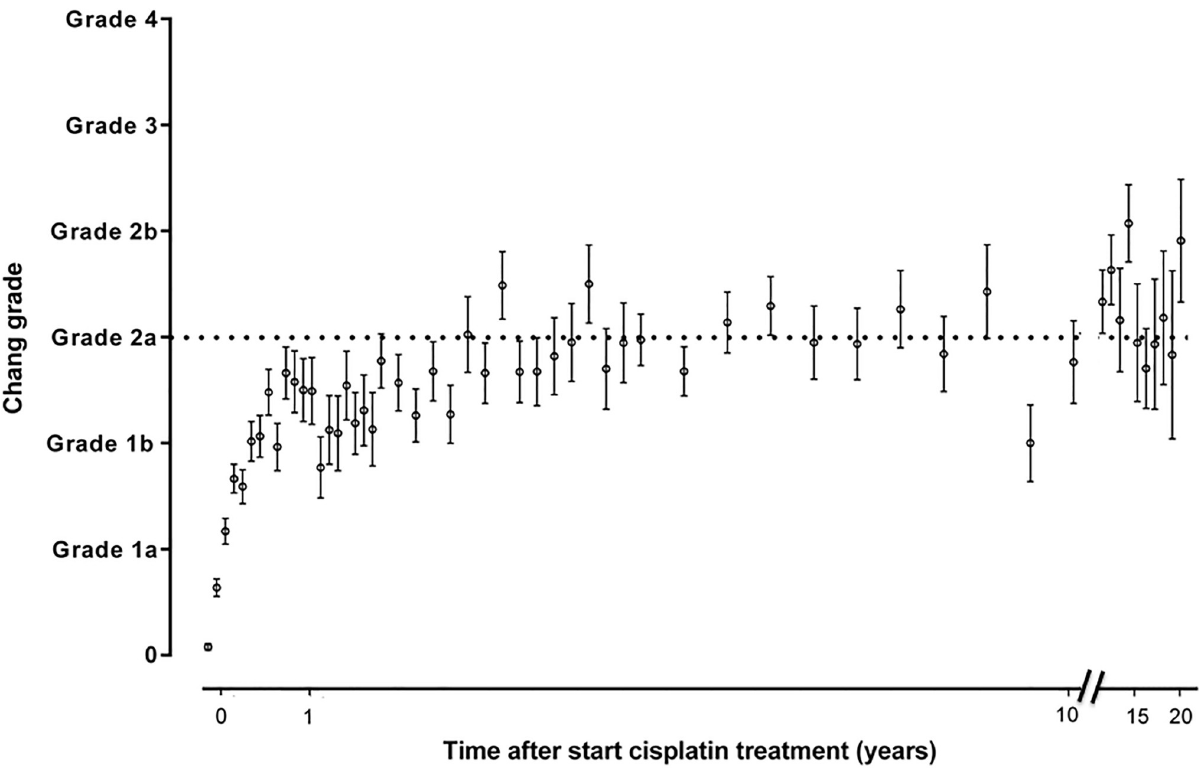
Fig 5. Progression of hearing loss based on Chang grade. The time after start cisplatin treatment in 654 patients is depicted on the x-axis and the hearing loss grade is depicted on the y-axis. The dots represent the mean and the whiskers represent the standard error of the mean ototoxicity grade. The dotted horizontal line depicts the cut-off for hearing loss